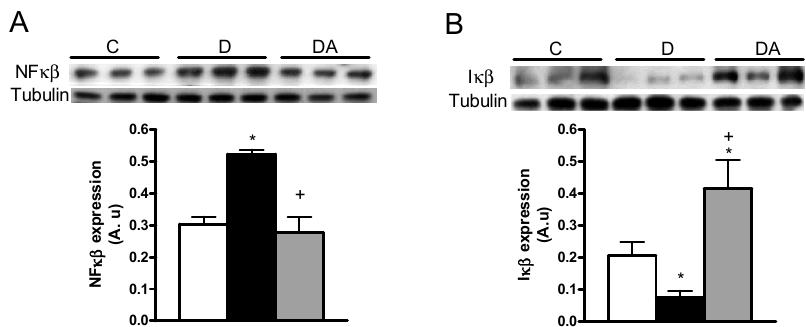
Figure 5. Effects of allicin on the expression of nuclear factor kappa beta (NF κ β ) ( A ) and its inhibitor (I κ β ) ( B ) in the kidney cortex. C, D and DA in figures represent the control, untreated diabetic and allicin-treated diabetic groups, respectively. Data represent the average of values from all the animals ( n = 6) in a given group ± SEM (* p < 0.05 vs. the control group; + p < 0.05 vs. the diabetic groups). To elucidate the anti-fibrotic effects of allicin, the transforming growth factor beta (TGF- β 1) protein was analyzed. As shown in Figure 6A,B, TGF- β 1 expression in the serum and kidney cortex from diabetic rats was significantly increased. Meanwhile, the allicin treatment markedly decreased the TGF- β 1 expression in the serum and the renal cortex (Figure 6A,B).